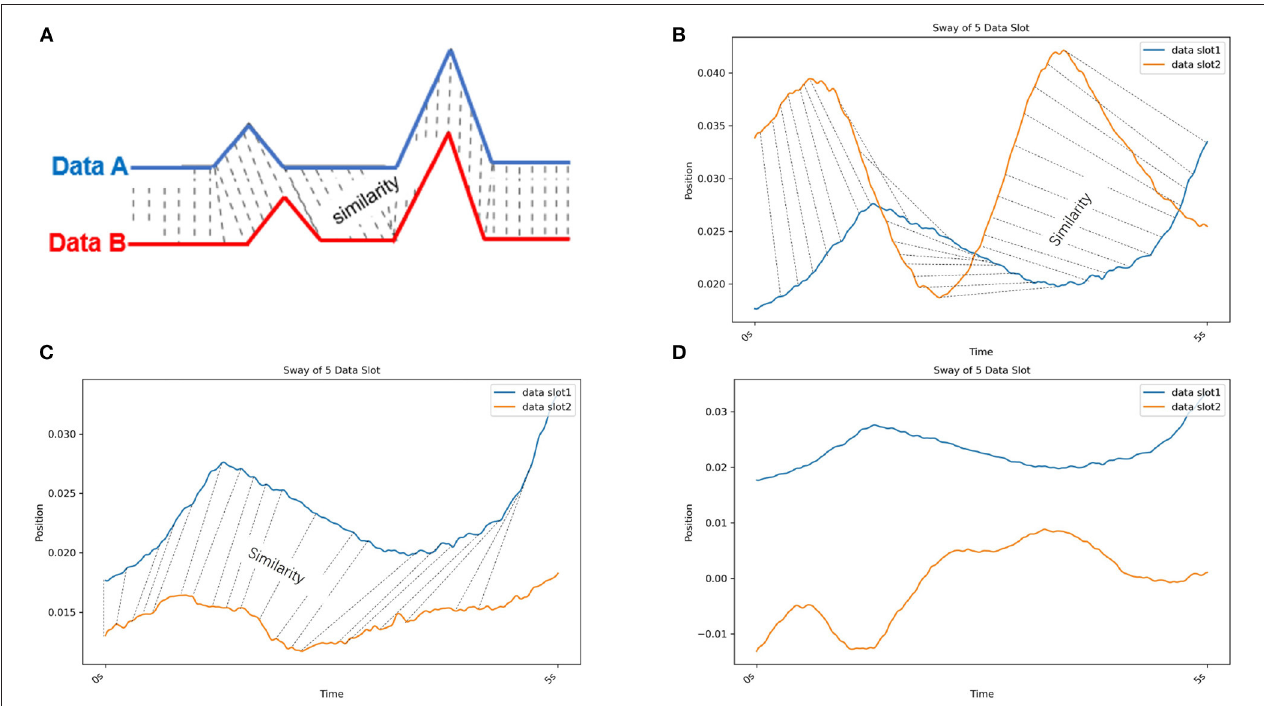
FIGURE 5 | (A) Dynamic time warping (DTW). DTW compares the similarity between two temporal sequences (Data A in blue and B in red) that can vary in speed. (B) Dynamic time warping (DTW) with real postural sway data from the same individual. The blue and orange lines are the COM X data of different data slots from CH2. (C) Dynamic time warping (DTW) with real postural sway data from different patients in the same cluster. The blue line is the COM X data of a data slot from CH2. Orange line is the COM X data of a data slot from CH3. (D) Dynamic time warping (DTW) with real postural sway data from different patients in different clusters. The blue line is the COM X data of a data slot from CH2. The orange line is the COM X data of a data slot from CH5. Because the similarity of these two data slots is low, no similarity lines could be drawn.